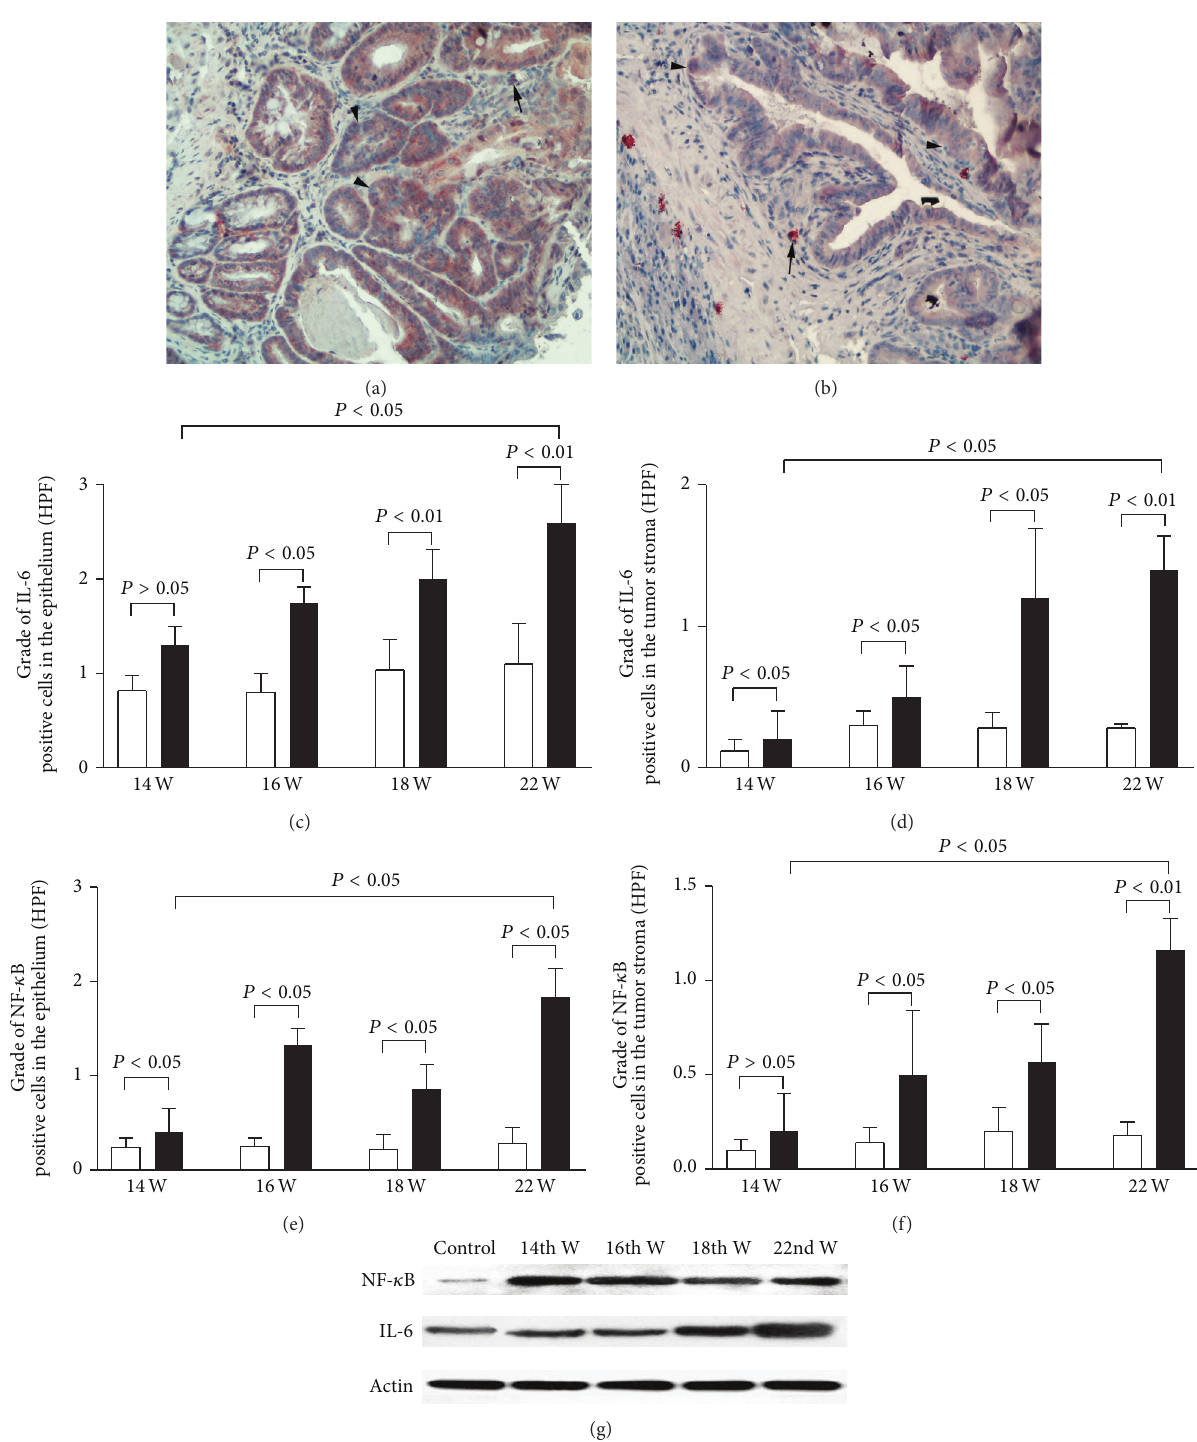
Figure 4: The expression patterns of IL-6 and NF- 𝜅 B positive cells in the tumor tissues over examined time-points. Represented immunohistochemical photos taken from CAC mice treated with DMH and DSS for 18 weeks showed that IL-6 (Figure 4(a)) and NF- 𝜅 B (Figure 4(b)) immunoreactivities were observed in both the transformed epithelium (arrow head pointed in Figures 4(a) and 4(b)) and tumor stroma (arrow pointed in Figures 4(a) and 4(b)). The cell density grading results confirmed the immunohistochemical observations anddemonstratedthatthedensitiesofIL-6(Figures4(c)and4(d))andNF- 𝜅 B(Figures4(e)and4(f))positivecellsinboththeCACepithelium and tumor stroma were significantly increased over examined time-points ( white bar for age matched control, black bar for dysplastic lesion at different examined time-points in Figures 4(c)–4(f)). The western blotting results revealed that both of the IL-6 and the NF- 𝜅 B proteins (Figure 4(g)) were increased in dysplastic tumor tissues after induction for 14 weeks and persisted to 22 weeks and confirmed the immunohistochemical observations as well (A&B: IHC images counterstained with hematoxylin, original magnification 200x; HPF: high power field; 𝑃 values in Figures 4(c)–4(f) were obtained with the Mann-Whitney U